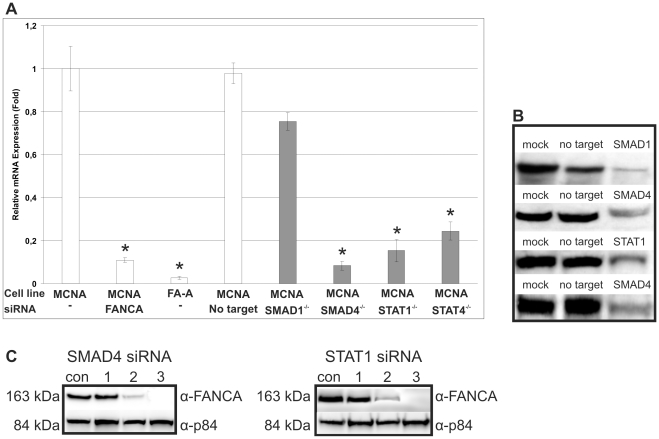

FANCA mRNA expression in normal control (MCNA) and FA-A (FA-A) primary human fibroblasts after siRNA treatment against SMAD1, SMAD4, STAT1 and STAT4.(A) Wild-type and FA-A controls (MCNA; FA-A) were left untreated. MCNA was also transfected with non-target siRNA. FANCA siRNA transfected con cells and patient-derived FA-A cells served as the positive controls. The results using primary fibroblast cell strains confirmed the results obtained in the HeLa cell system. (B) A western blot showing the effective transcription factor knockdown. (C) Depletion of FANCA protein was detected by an anti-FANCA antibody to determine the effectiveness of the knockdown at the protein level. Control untreated (lanes 1). SMAD4 and STAT1 siRNA-treated cells showed marginally detectable FANCA protein (lanes 2). FANCA-mutated (FA-A) cells are shown for comparison (lanes 3). The nuclear matrix protein (p84) served as a loading control.